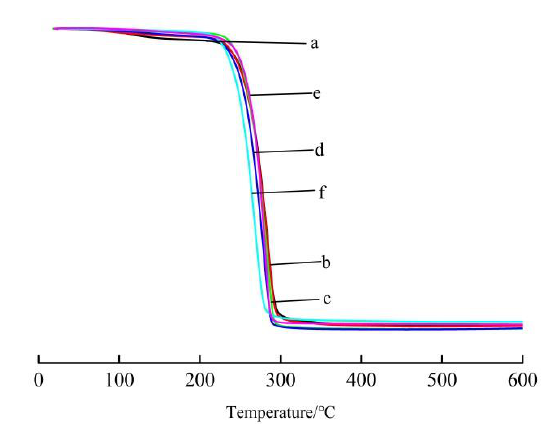
Figure 5. TGA curves of PLLA and sc-PDLAG samples with different glucose content in feeding; glucose content in the feeding of samples (%): a. 5%; b. 4%; c. 2%; d. 1%; e. 0.5%; f. PLLA. Table 3. Characteristic temperatures of PLLA, PLLAG, and sc-PLAG samples determined by TGA. Sample Glucose Content in Feeding/%